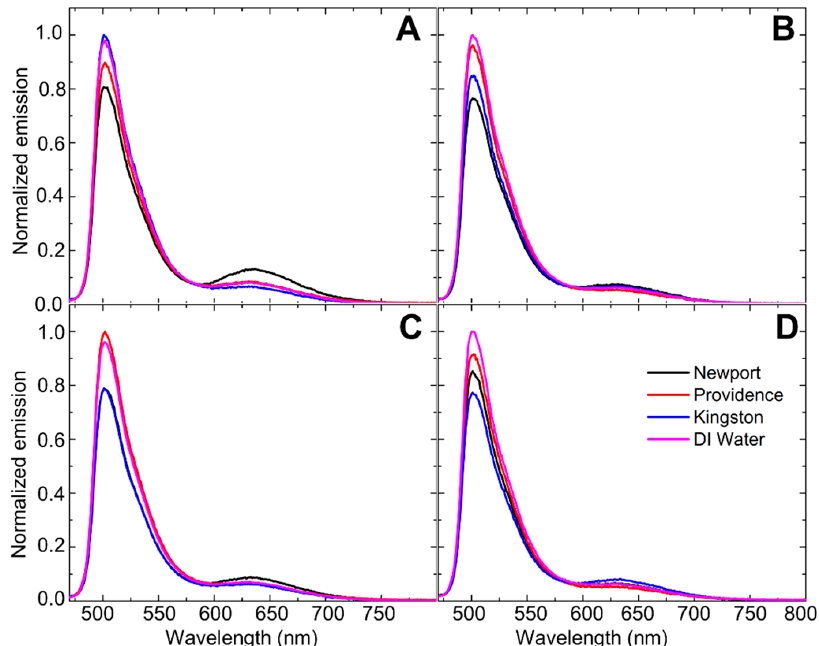
Figure 7. Fluorescence changes of fluorophore 9 ( λ ex = 460 nm) with ( A ) analyte 1 with β -cyclodextrin; ( B ) analyte 1 with phosphate-buffered saline; ( C ) analyte 8 with β -cyclodextrin; and ( D ) analyte 8 with phosphate-buffered saline in the different sampling locations. The black line represents Newport snow, the red line represents Providence snow, the blue line represents Kingston snow, and the purple line represents deionized water. Table 2. Literature-reported binding constants of analytes 1 – 7 with β -cyclodextrin a . Compound